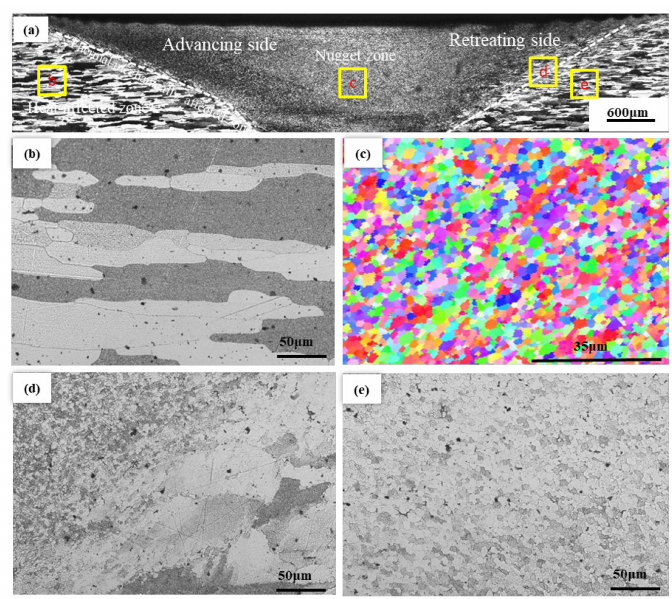
Figure 7. Microstructure of base metal in 3D and EBSD map of crossing section ( a ) A 3D demonstra- tion of base metal; ( b ) EBSD investigation of crossing section microstructure of base metal. The cross-microstructure of robotic FSW 2198 at 100 mm/min is given in Figure 8. There are three areas in weld joints, including the nugget zone, thermo-mechanically affected zone, and heat-affected zone, as shown in Figure 8a. The nugget zone consisted of refined equiaxed grains, as shown in Figure 8c. The EBSD test demonstrated that the average grain size in the nugget zone is 10 µ m, much smaller than that of the base metal. The refined grains were related to the recrystallization caused by severe deformation and high temperature during the FSW process [26–28].